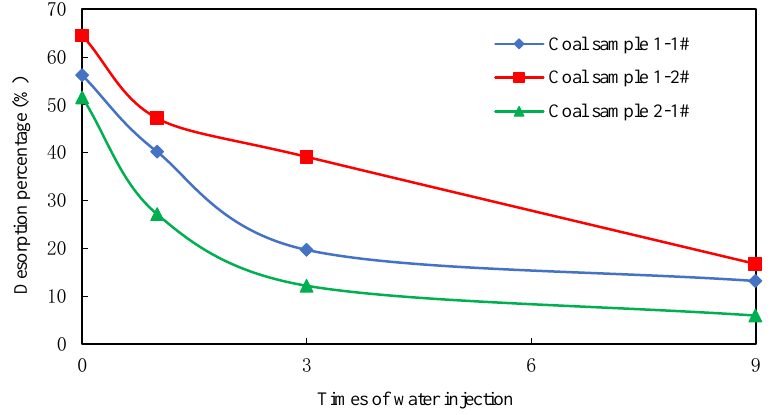
Figure 6. Permanent desorption percentage as a function of water injection pressure for the three coal samples studied in this paper (0 of x -axis represents natural desorption stage without water injection). Table 3. Desorption and moisture values after experiments Coal Sample No.